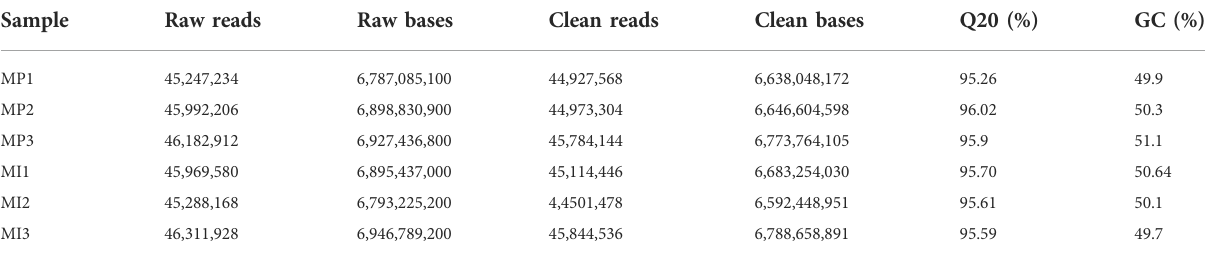
TABLE 2 Summary of heart transcriptome sequencing for E. sinensis .